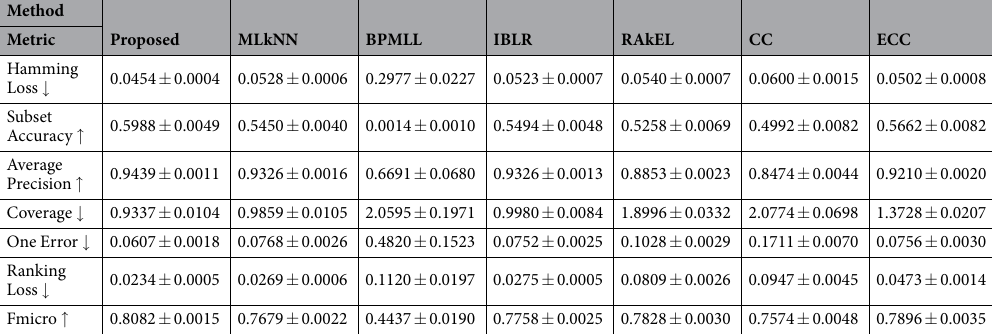
Table 4. Metric values of different multi-label learning methods through 5-CV on the original dataset. ↓ means lower is better; ↑ means higher is better.